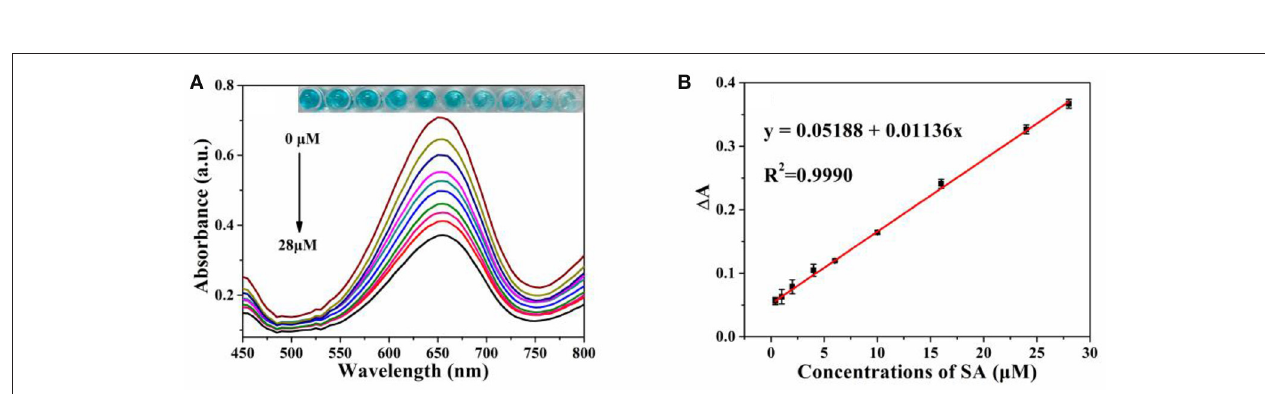
FIGURE 6 | (A) The vis absorption spectra of MIL-53(Fe)-TMB-H 2 O 2 upon concentrations of SA (from 0 to 28 µ mol L − 1 ). Inset: the corresponding photograph of the colored products; (B) The linear relationship between absorbance intensity ( 1 A) and SA level. Error bars represent the standard deviation of three trials.